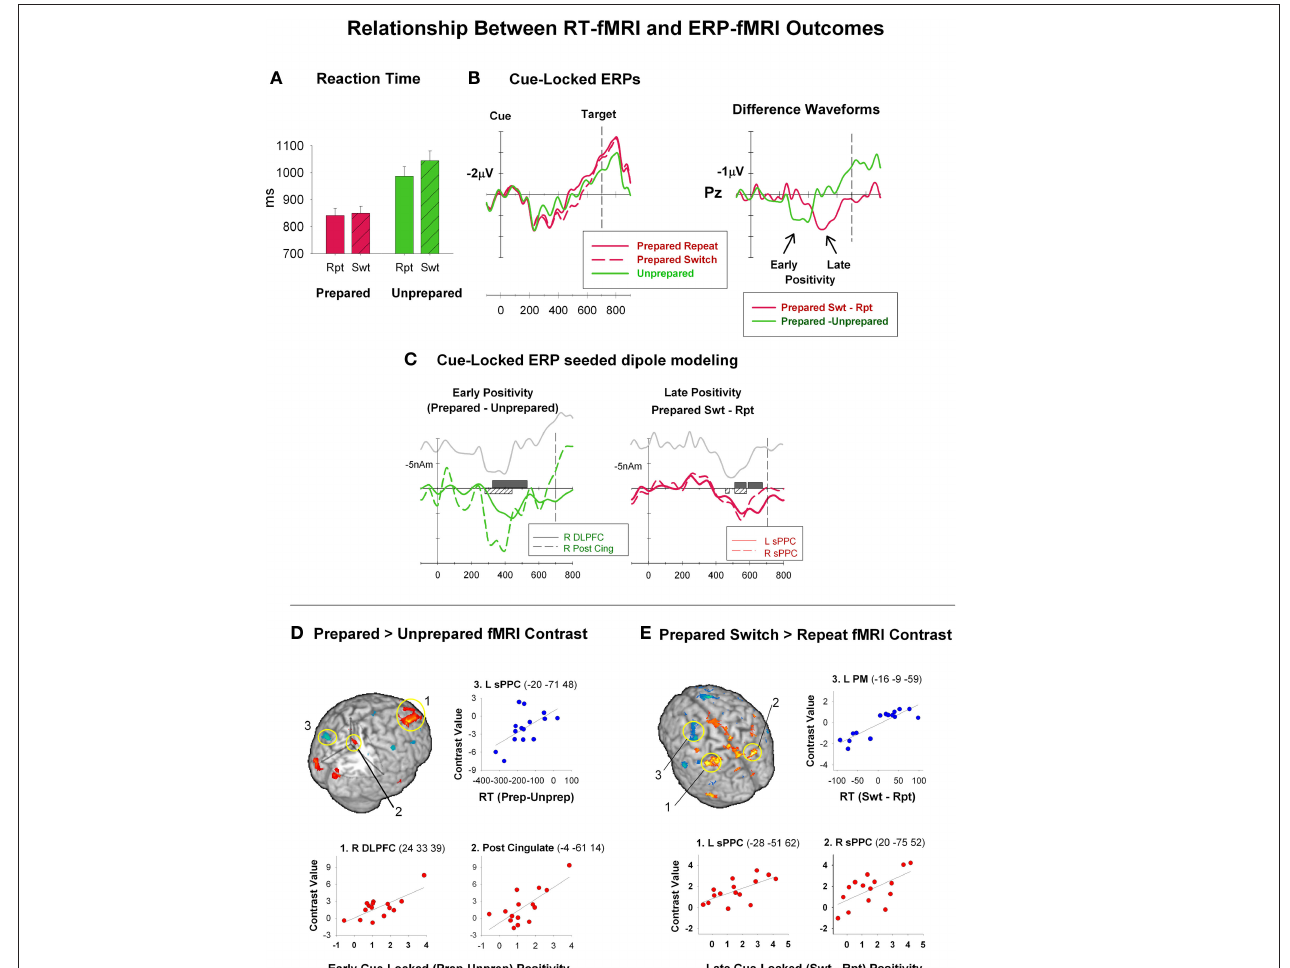
FIguRE 3 | Event-related brain potentials (ERP) are extracted from the electroencephalogram (EEg) through a process of signal averaging and filtering. ERPs represent time-varying scalp fields that result from summation of post-synaptic electromagnetic activity generated by neuronal populations in different parts of the brain (Otten & Rugg, 2005). While the location of neuronal generators of ERP activity cannot be directly inferred from scalp